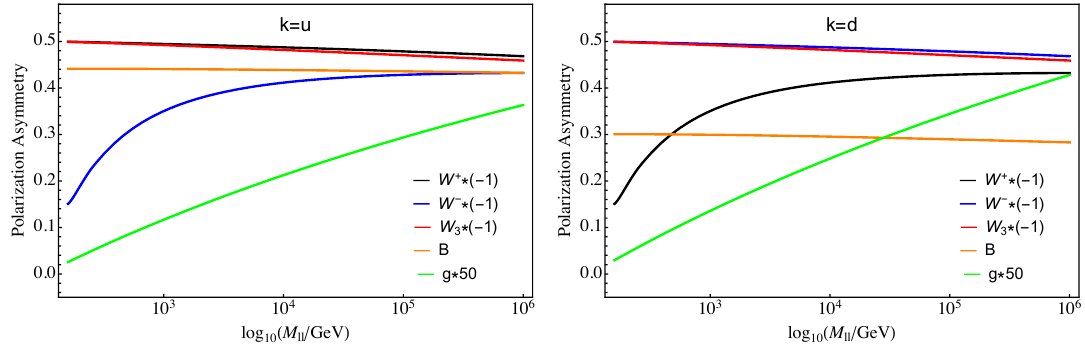
Figure 4 . The absolute value of the polarization asymmetry, de(cid:12)ned as A ( V ) = ( h d k